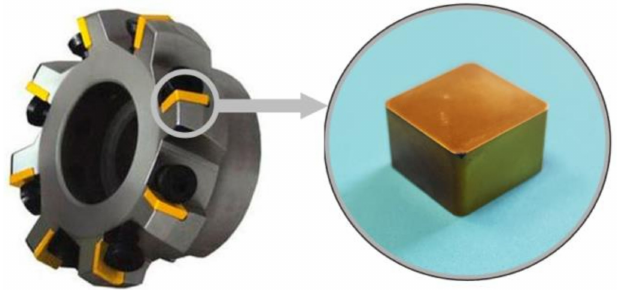
Figure 2. The construction of the end mill with replacement ceramic inserts with coatings used in the process of